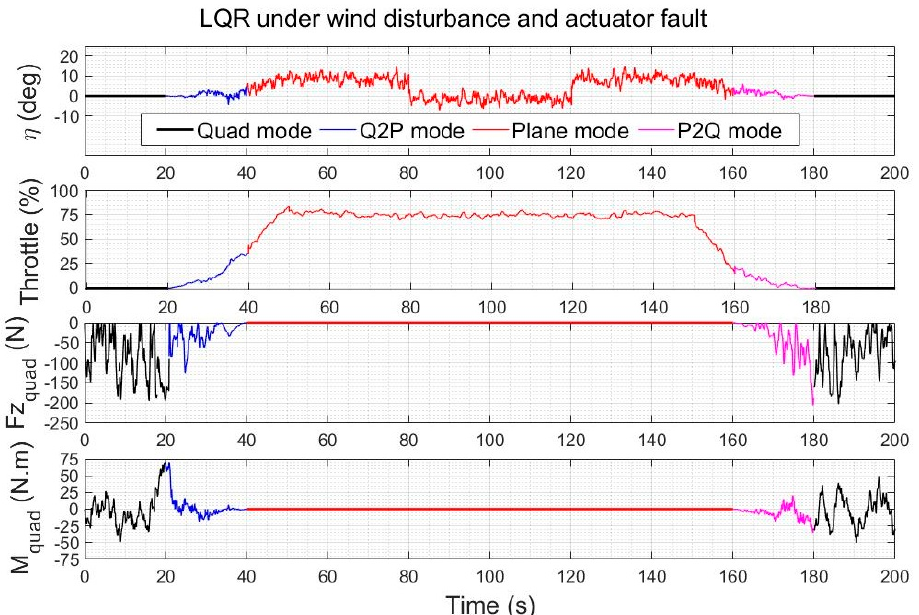
Figure 18. Quadplane control inputs using LQR during a climb − cruise − land manoeuvre under winds and an elevator fault between 80 s and 120 s.